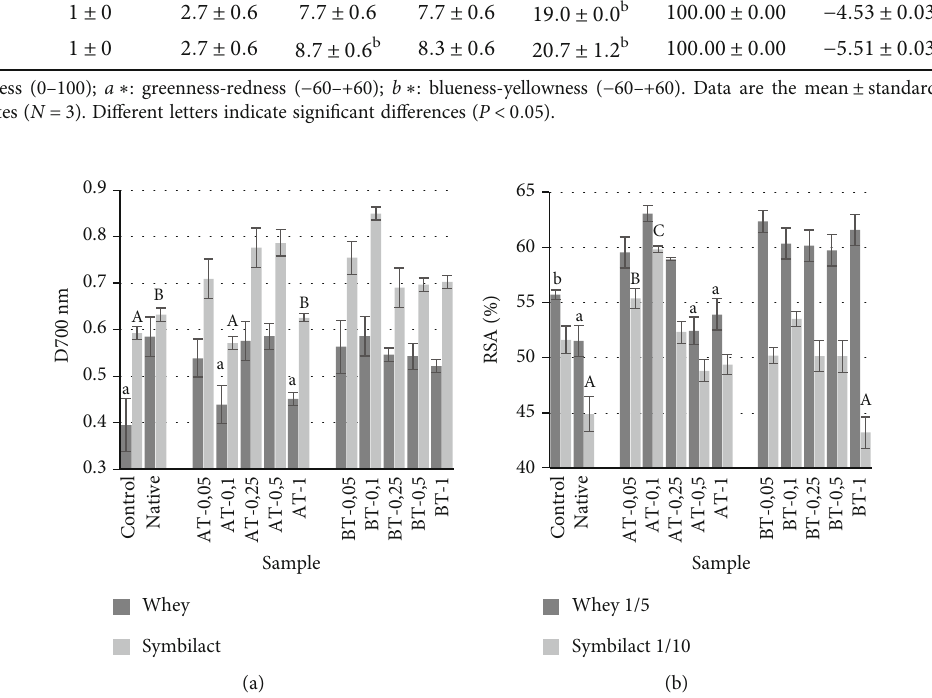
Figure 2: FRAP (a) and DPPH-scavenging activity (b) of Symbilact samples added with di ff erent starches after 28 days of storage. Data are the mean ± standard deviation of independent replicates ( N = 3 for FRAP, N = 5 for RSA). Di ff erent letters indicate signi fi cant di ff erences ( P < 0 : 05 ).